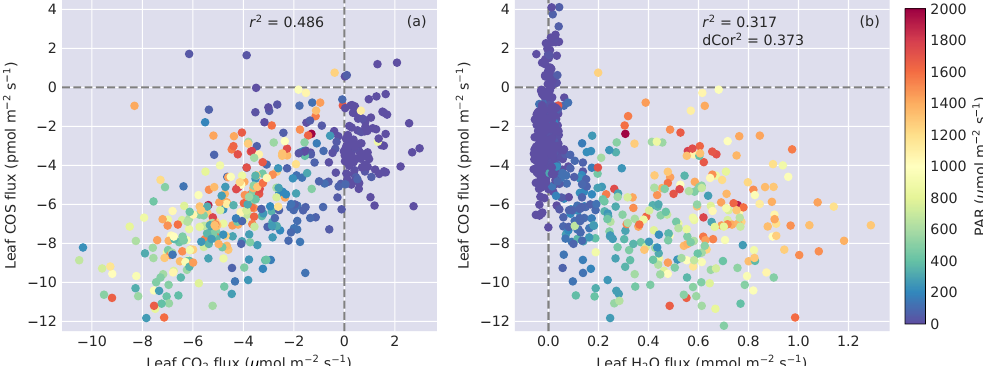
Figure 4. (a) Leaf COS vs. CO 2 fluxes, and (b) leaf COS vs. H 2 O fluxes. Data points are colored by the PAR level.